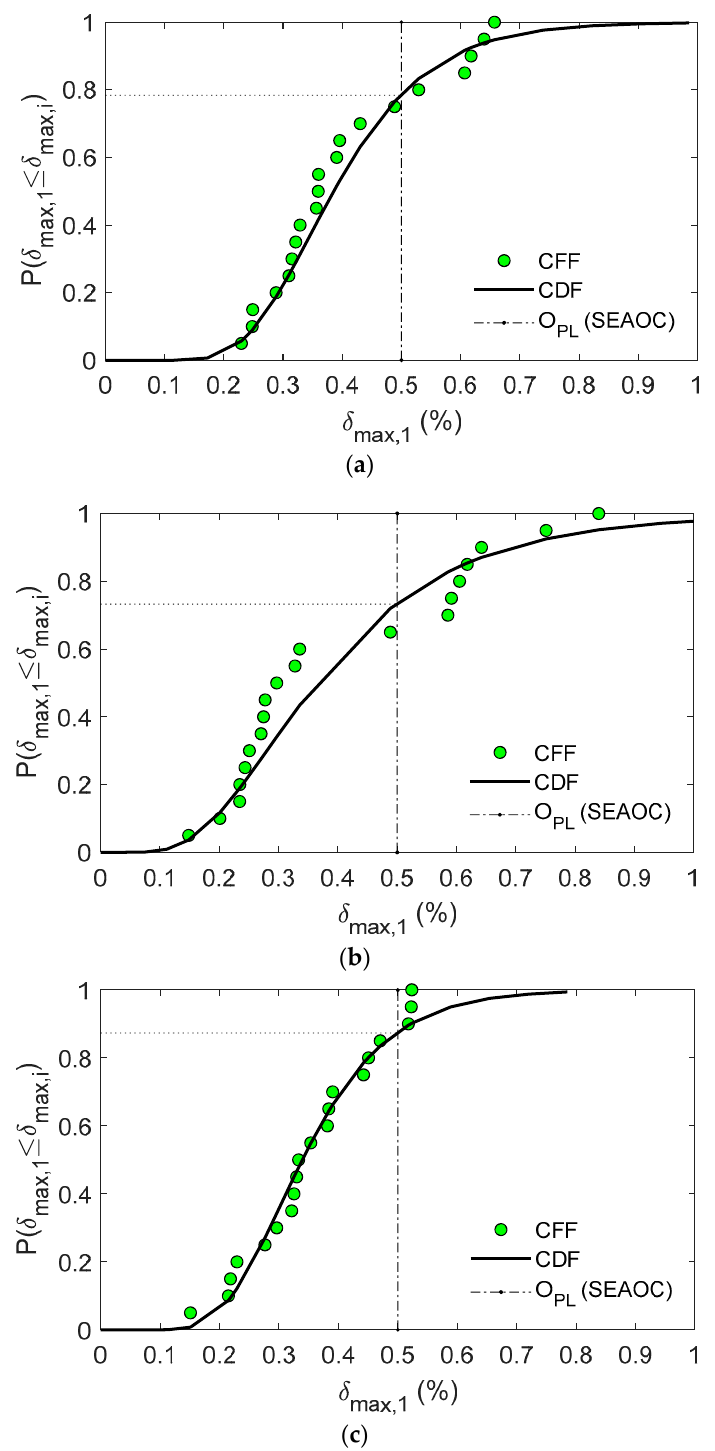
Figure 7. Cumulative distributions for prototypes N3 ( a ), N6 ( b ) and N9 ( c ).